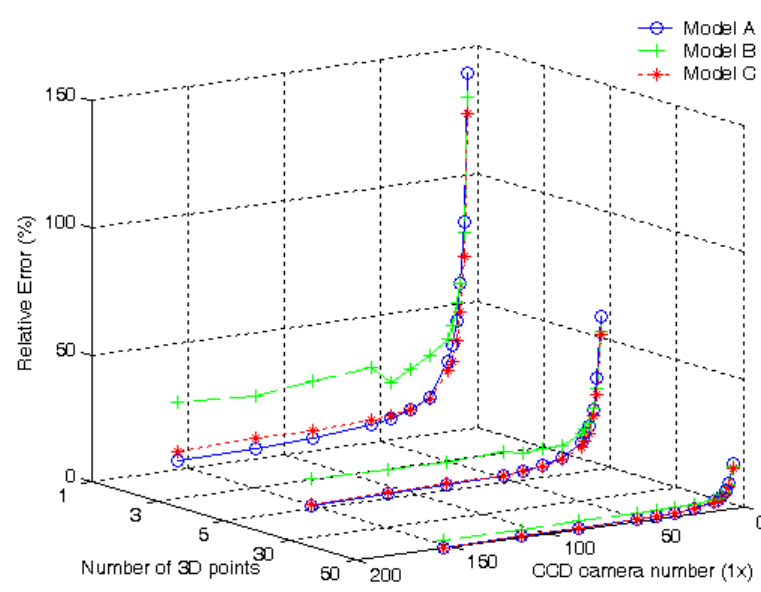
Figure 5. The relative errors of translation motion in three models with a single, five, and fifty 3D points under a noise level of variance 100.